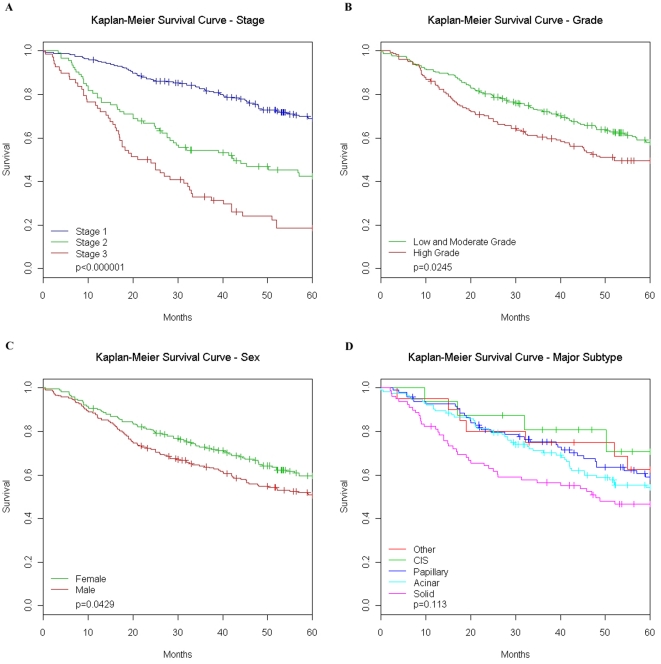
Stage, grade, sex and pathology effects on survival.Log-rank tests of differences between Kaplan Meier survival curves verify that the dataset is consistent with previous results. Higher stage patients do significantly poorer as compared to lower stages (A) and high grade patients (B) (poor differentiation) have increased hazards compared to low or intermediate grade patients. Gender is a marginally significant prognostic indicator; males have poorer survival (C). Additionally we examined pathology (D) defined by major lung adenocarcinoma (AD) subtype (plurality of tumor cross section). There was no significant overall difference between the four main subtypes as well as tumors that did not fall into one of these categories. Abbreviations: CIS, carcinoma in situ.